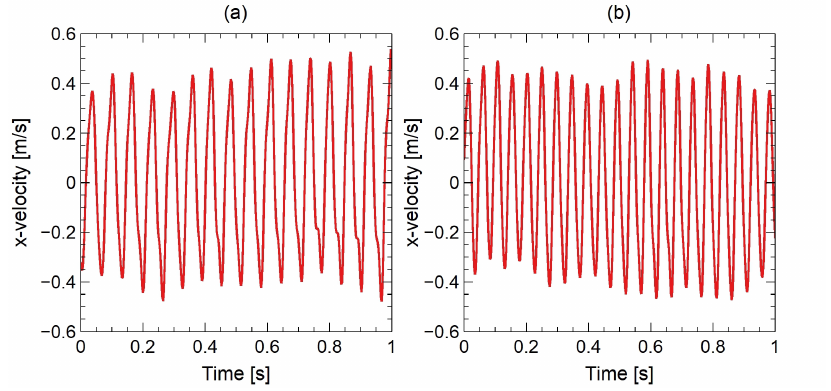
Figure 6. x velocity component during 1 s at y / B = 4 for ( a ) Re = 340 and ( b ) Re = 480.